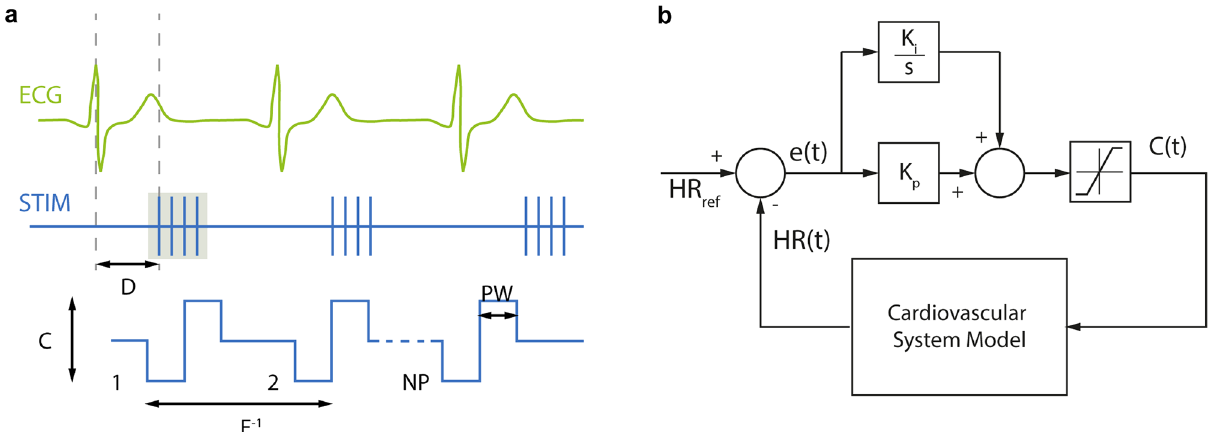
Figure 1. Overview of the stimulation paradigm and the control strategy implementation. ( a ) Cardiac- synchronized stimulation, as is defined by its five main parameters: current amplitude, C, pulse width, PW, frequency, F, number of pulses per burst, NP, and stimulation onset delay, D, electrocardiogram (ECG), stimulation signal (STIM). ( b ) Block diagram of the proportional-integral controller as used during in-silico development. Reference heart rate, HR ref , measured heart rate, HR(t), integral gain, K i , proportional gain, K p , calculated error, e(t), current amplitude,